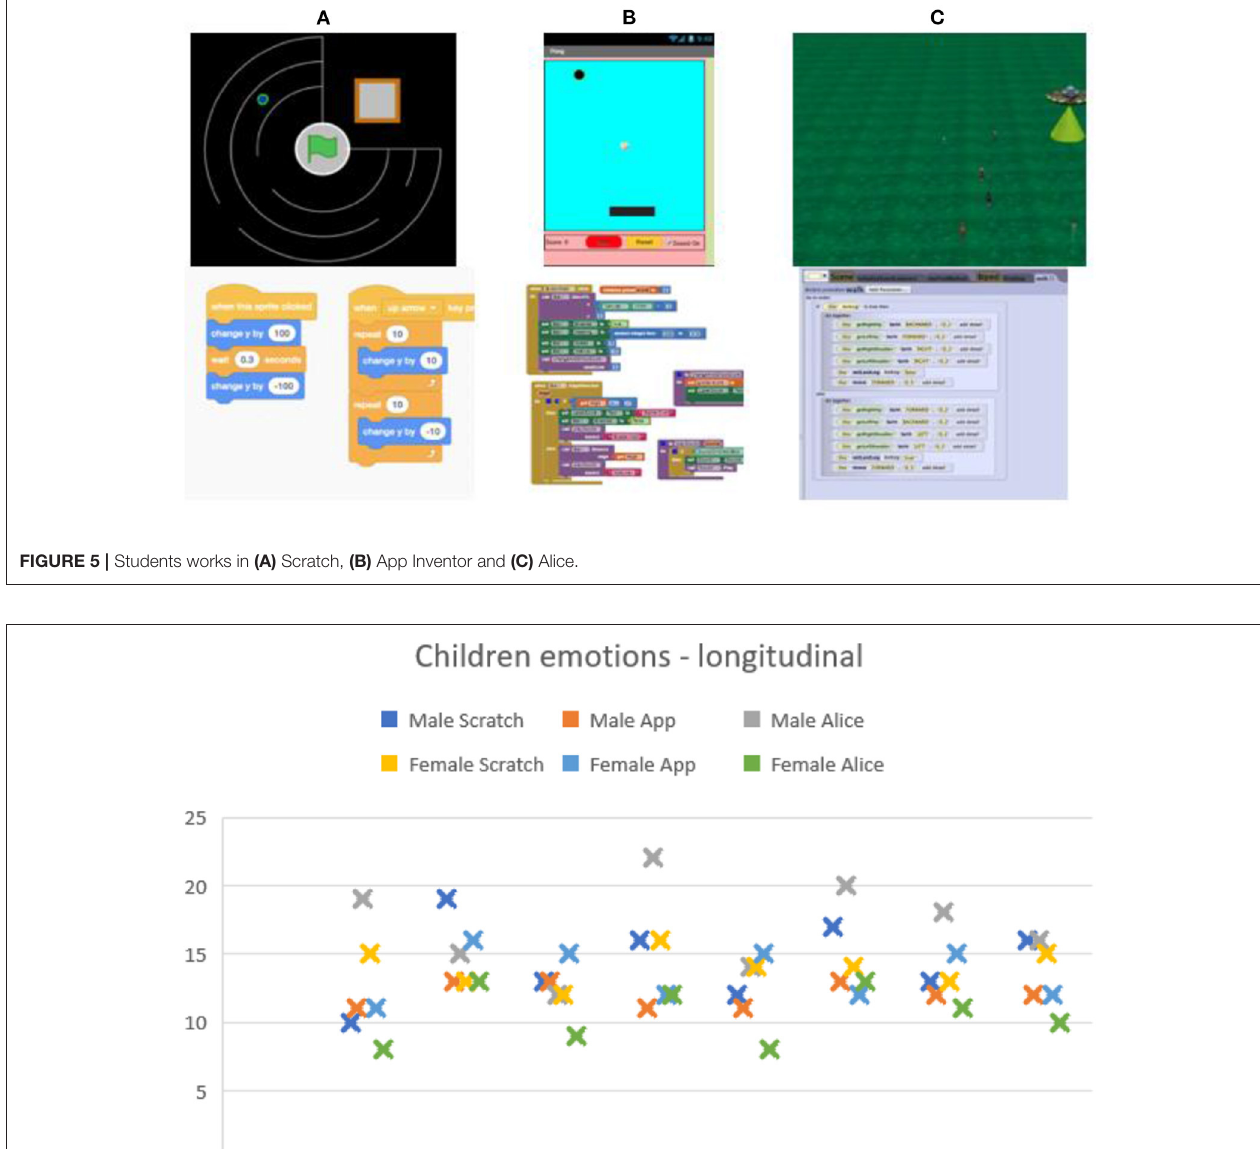
accepted by students and we would recommend its use to instructors, after a programming introduction with Scratch, in align with (Papadakis et al.,